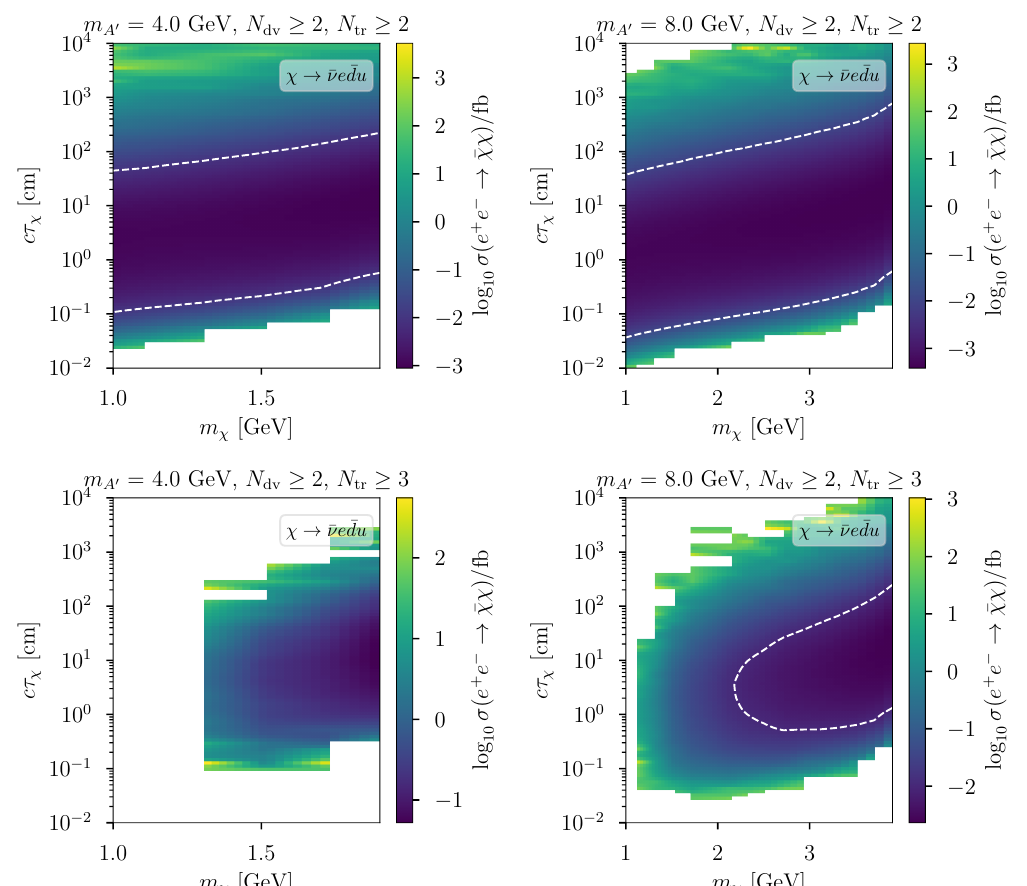
Figure 8 . Cross-section sensitivity in fb of Belle II based on 10 signal events in a 50 ab − 1 dataset for LLPs χ decaying to νe + hadrons and the dark photon production mode. The upper (lower) row shows the result of demanding at least 2 (3) charged tracks from two displaced vertices. The left (right) column fixes m = 4 ( 8 ) GeV. The white dashed contours correspond to a production A 0 cross section of 10 − 2 fb , which is roughly equivalent to ε ∼ 10 − 5 for m 8 GeV . A 0 ≤ the backgrounds to LLP searches are very rare, and so increasing either the multiplicity of vertices or the number of tracks per vertex can suppress